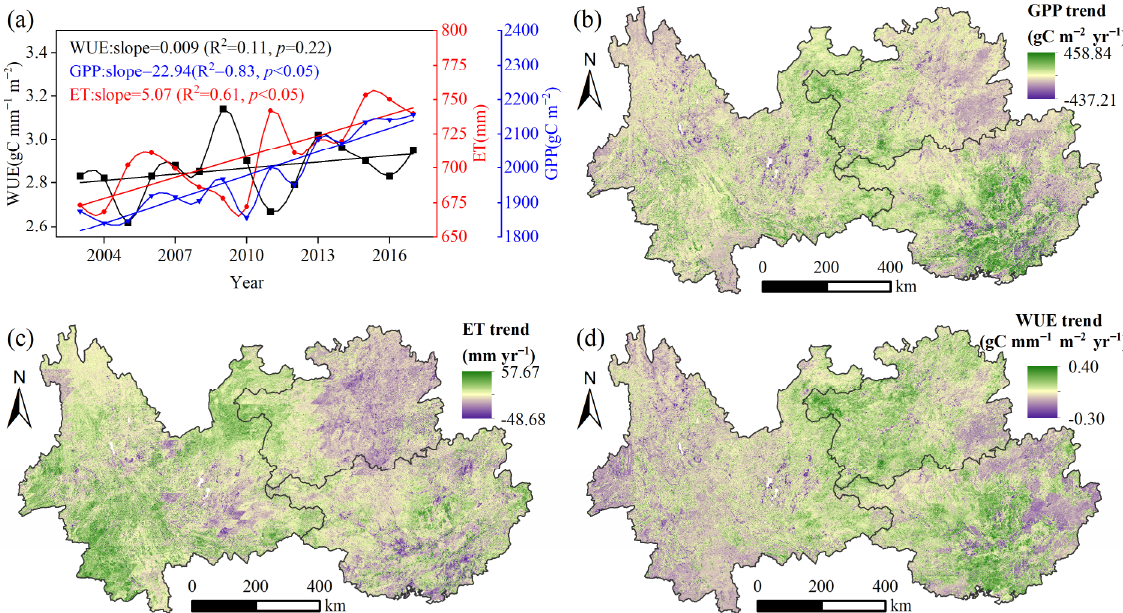
Figure 3. ( a ) Interannual variations of GPP, ET, and ecosystem WUE from 2003 to 2017. Spatial trends of ( b ) GPP, ( c ) ET, and ( d ) ecosystem WUE. of ( b ) GPP, ( c ) ET, and ( d ) ecosystem